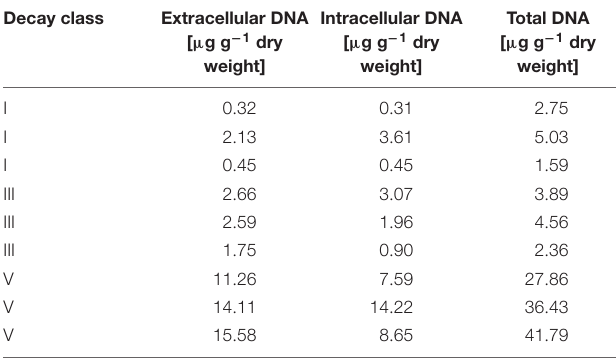
TABLE 1 | Total, intra- and extracellular DNA concentrations in the three decay classes (DCl I, III, and V). Decay class